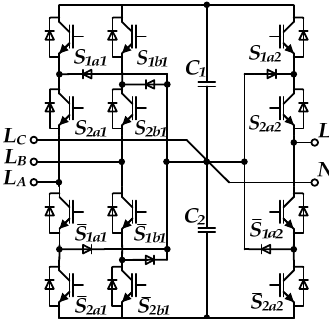
Fig. 1. Simplified AC/DC/AC multilevel NPC converter.